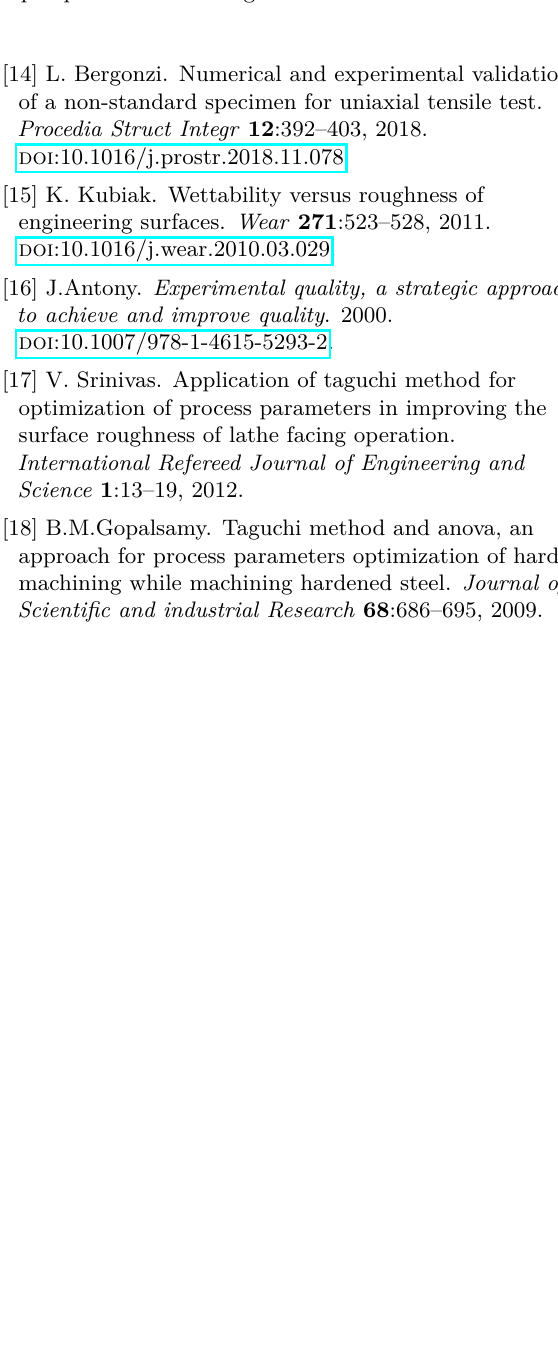
Table 6. Configurations for single lap experimental